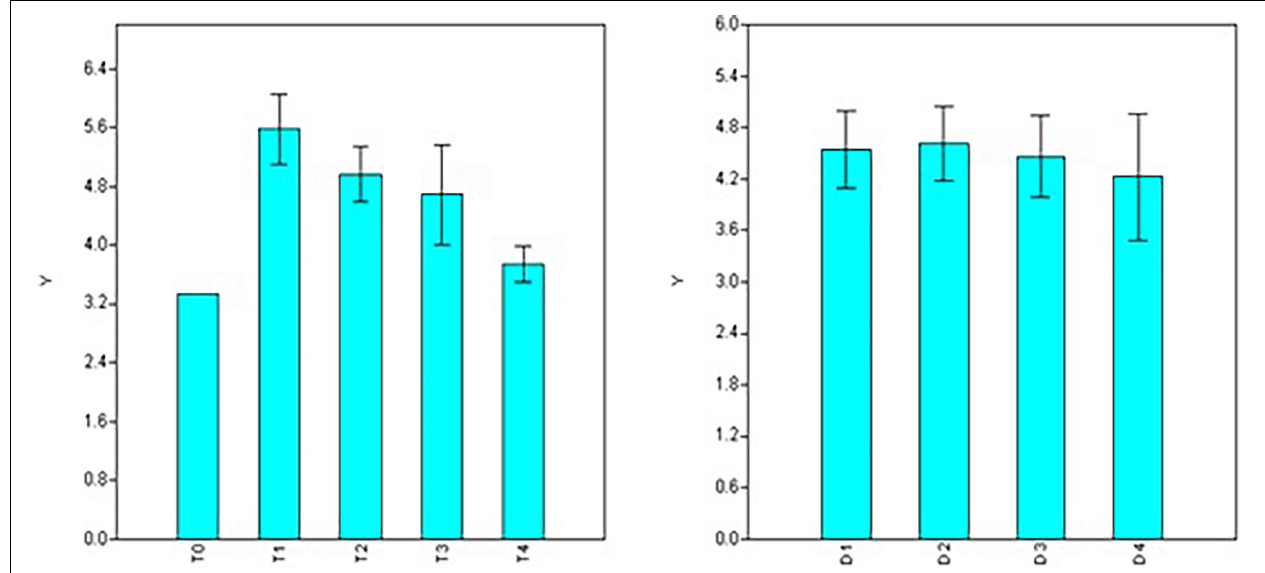
FIGURE 2 | Effect of NAA doses (left) and durations (right) on number of roots formed in apical shoots of Valeriana jatamansi .